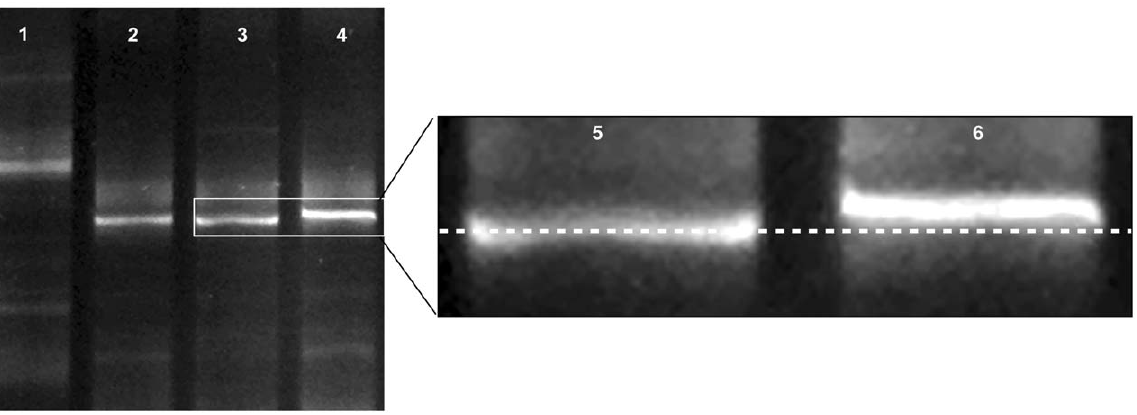
Figure 8. Resolution via DGGE of a single nucleitide difference in segment 5. Lane 1 segment 5 with insert, lanes 2–3 segment 5 without insert and Q 266 , and lane 4 segment 5 without insert and L 266 (for accession numbers see Table 1). doi:10.1371/journal.pone.0037353.g008 PLoS ONE |